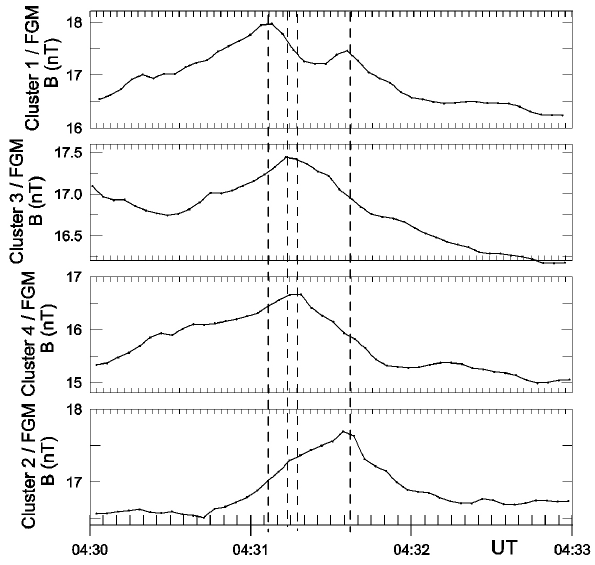
Fig. 6. Magnetic field amplitude variations (in nTs) for all four Cluster satellites, as they approach the lobe structure characterized with increased strength.